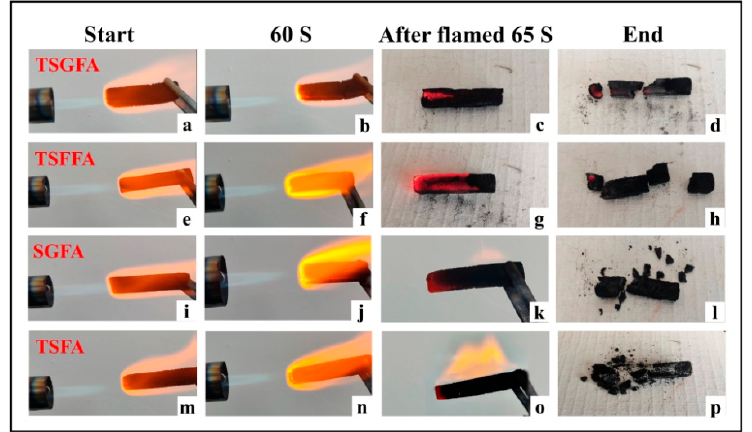
Figure 7. Flame retardancy of tannin–starch-based foams; optical images of ( a ) TSGFA-, ( e ) TSFFA-, ( i ) SGFA-, and ( m ) TSFA-based foams before flaming, and the corresponding samples after being flamed; ( d ) TSGFA, ( h ) TSFFA, ( l ) SGFA, and ( p ) TSFA foams while at 60 s after flaming started; ( b ) TSGFA-, ( f ) TSFFA-, ( j ) SGFA-, and ( n ) TSFA-based foams while after 65 s after flaming started; ( c ) TSGFA-, ( g ) TSFFA-, ( k ) SGFA-, and ( o ) TSFA-based foams.